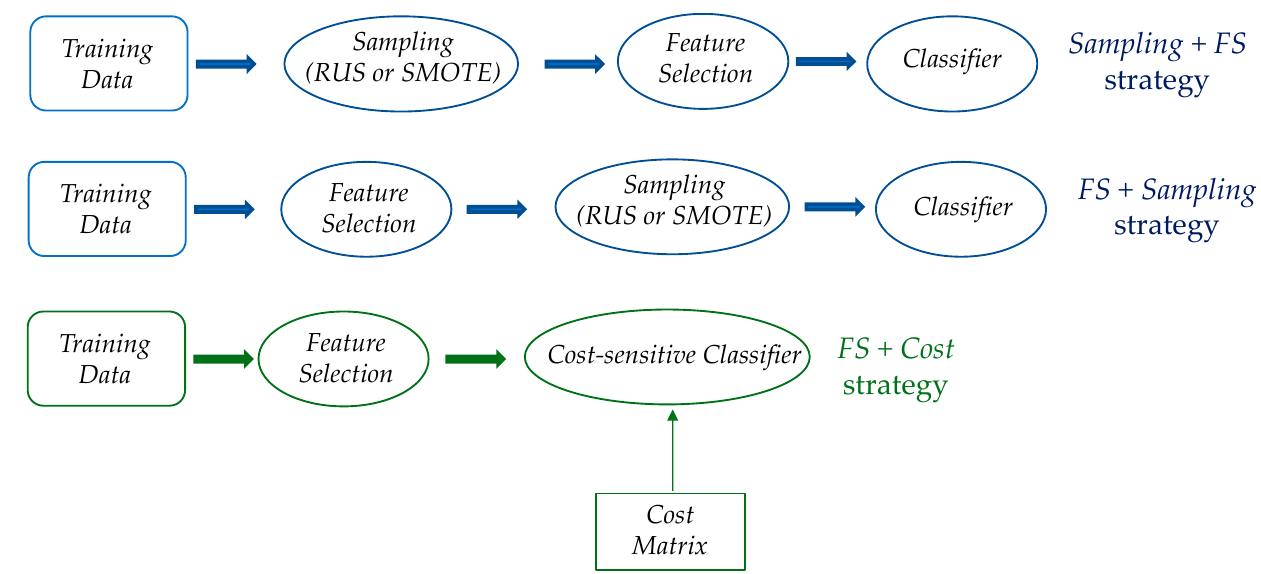
Figure 1. Hybrid learning strategies that combine feature selection with imbalance learning methods.